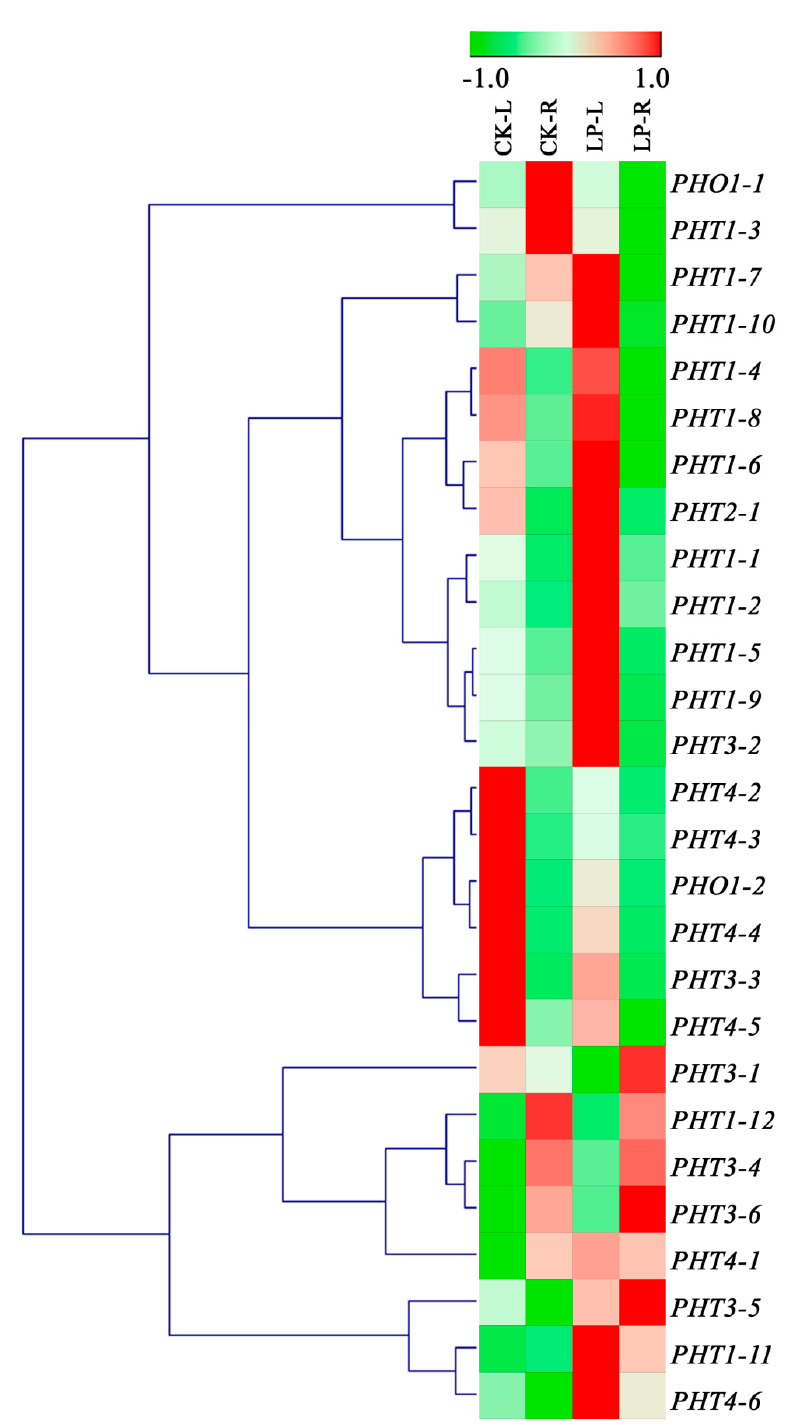
Figure 5. The relative expression levels of SbPHT genes in shoots and roots under normal and low-phosphate conditions. qRT-PCR analysis of SbPHT genes in the different tissues of 14-d-old Sorghum seedlings, including leaves under normal (CK-L) or low-phosphate (LP-L) growth conditions, and roots under normal (CK-R) or low-phosphate (LP-R) growth conditions. For each experiment, at least three independent biological replicates and three technical repetitions were assayed. PP2A and EIF4A were chosen as internal controls. The relative expression levels of the corresponding genes in comparison to the housekeeping genes were used to draw the figure in Genesis software. The red and green colors are presented by log transformation value with